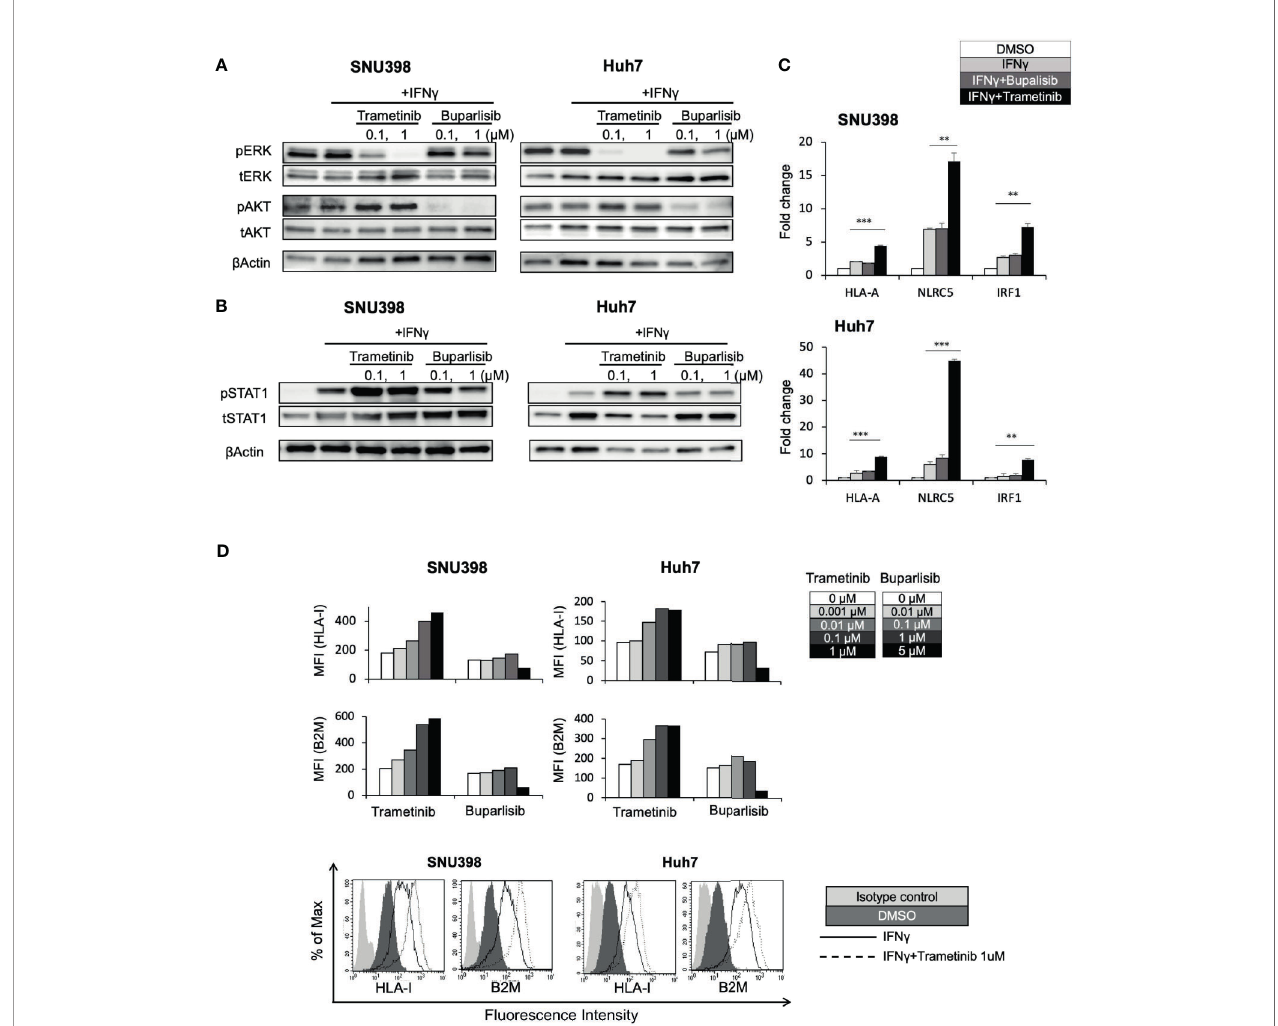
FIGURE 4 | Downregulation of the MEK/ERK pathway is involved in regorafenib-induced STAT1 phosphorylation and HLA-I expression. SNU398 or Huh7 cells were cultured with trametinib or buparlisib at the indicated concentrations in the presence of IFN g (1 ng/mL) for 24 hours (A) or for 72 hours (B) and then, ERK, AKT, and STAT1 protein levels were analyzed by Western blotting. b -actin is used as a loading control. (C) Cells were treated with buparlisib (0.1 m M) or trametinib (0.1 m M) for 48 hours with IFN g . HLA-A, NLRC5 and IRF1 mRNA expression was analyzed using real-time PCR. Data are expressed as fold change relative to vehicle-treated cells. (D) Cells were treated with trametinib or buparlisib at the indicated concentrations with IFN g for 72 hours. HLA-I and B2M surface protein expression were analyzed by fl ow cytometry and presented as MFI. A representative fl ow cytometry histogram is shown. (**: p < 0.01, ***: p <